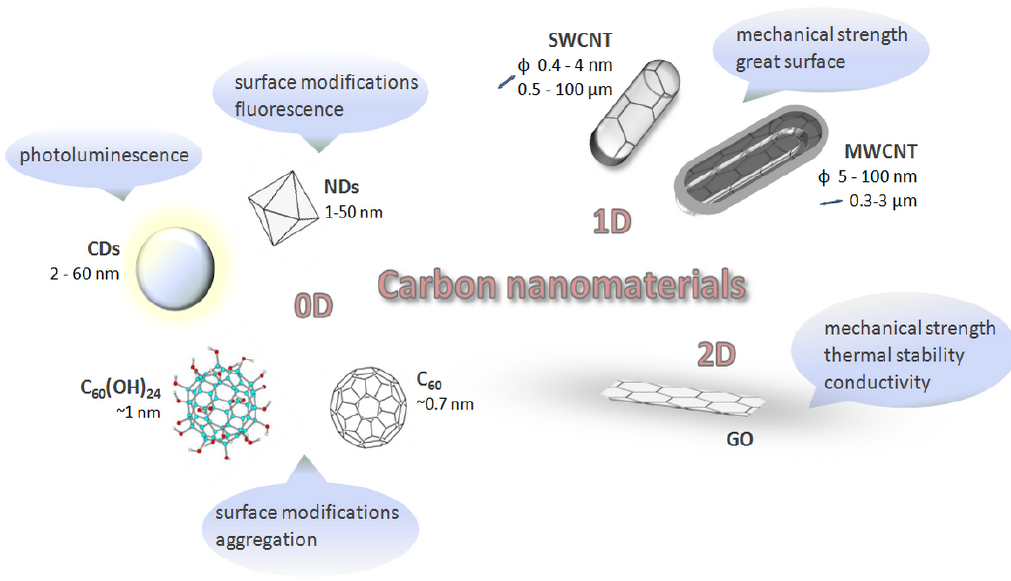
Figure 2. The main physicochemical properties of different nanostructures fullerene (C 60 ); fullerenol (C 60 (OH) 24 ); carbon dots (CDs); nanodiamonds (NDs); single-walled carbon nanotube (SWCNT); multi-walled carbon nanotube (MWCNT); graphene oxide (GO).